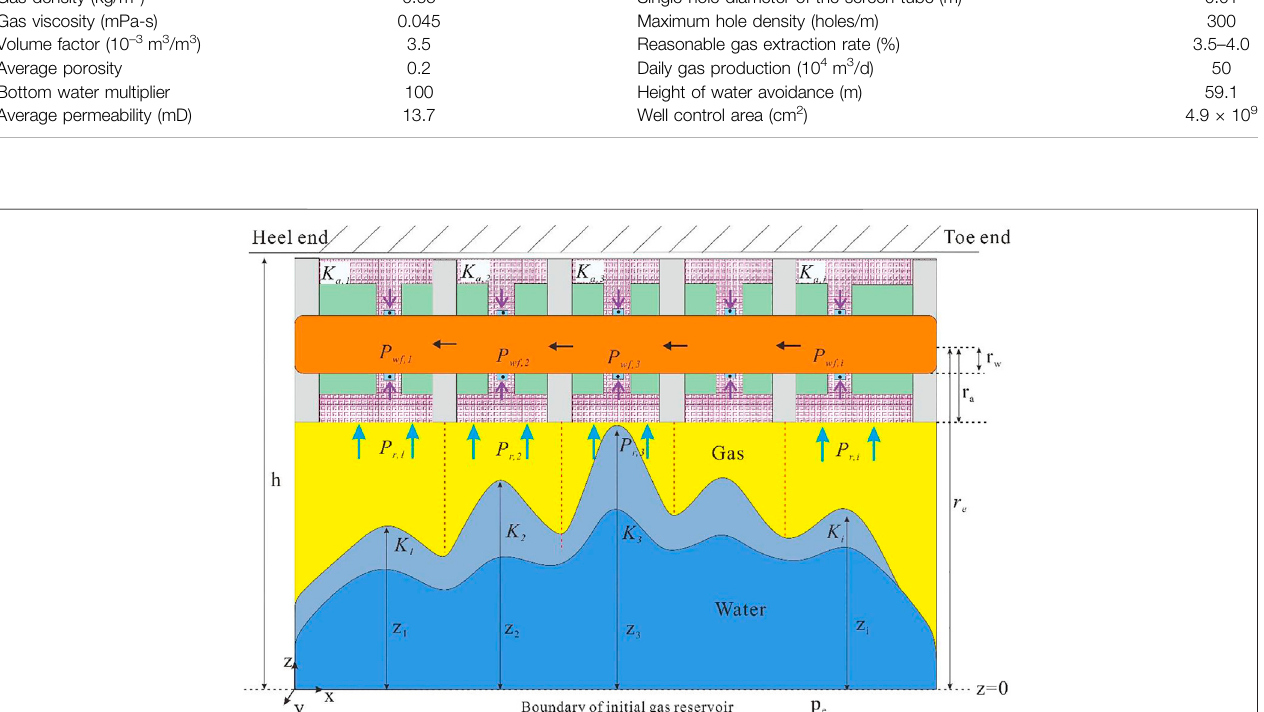
FIGURE 1 | Compound water control process production pressure drop